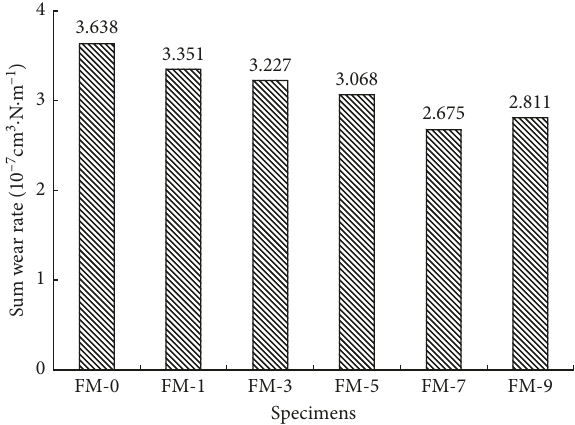
Figure 9: The sum wear rates of friction